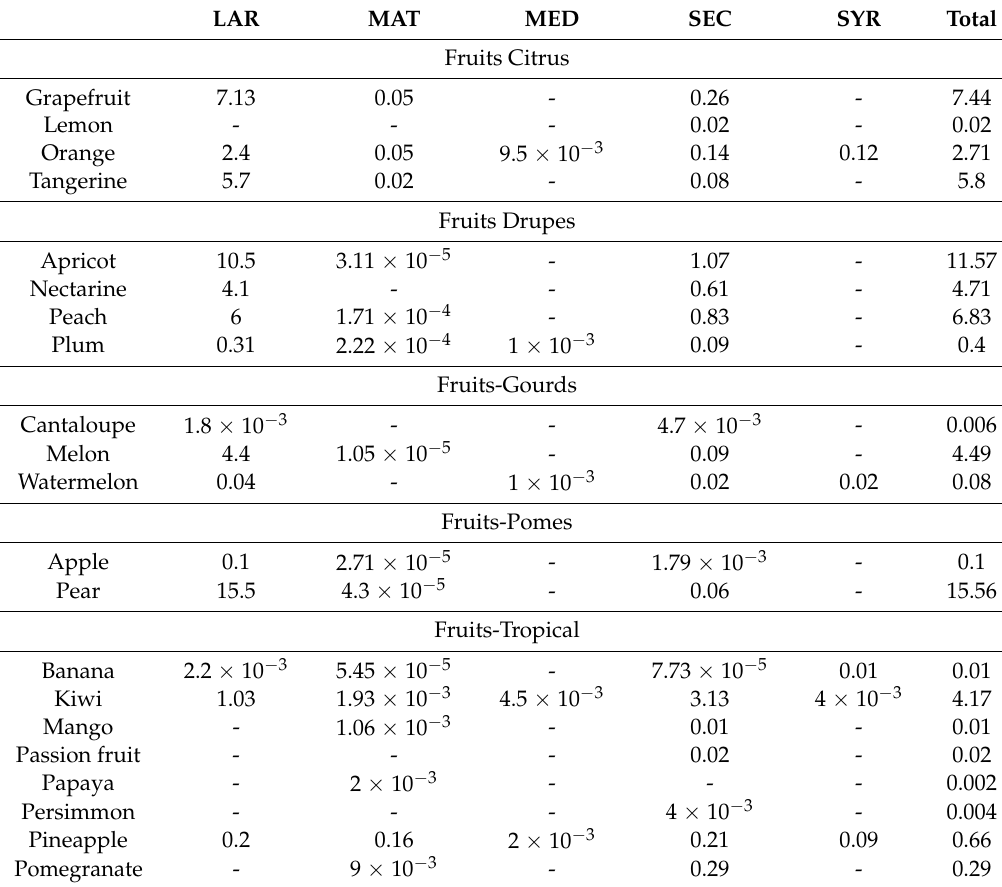
Table 6. Lignan contents of fruits (mg/100g food)